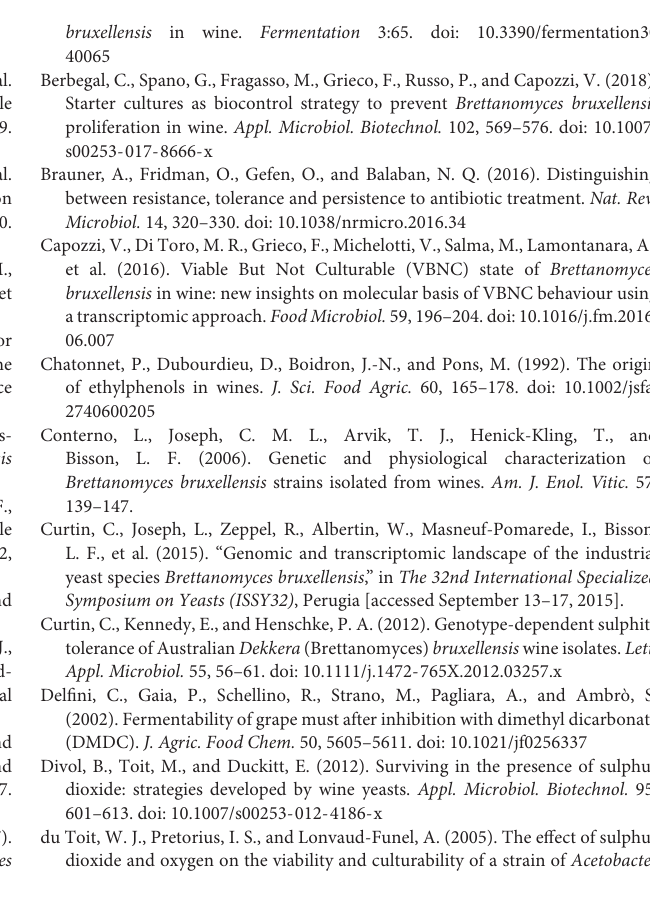
FIGURE S1 | Growth parameters of 145 B. bruxellensis isolates grown at different SO 2 concentrations. Growth parameters lag phase (h), maximum growth rate (division per hour), and maximum OD (600 nm) are presented for 145 isolates. Isolates are clustered by genetic group as defined previously (Avramova et al., 2018), in order: CBS 2499-like group (dark cyan), KOM1449-like (light green), AWRI1608-like (orange), AWRI1499-like (red), dark blue (CBS 5513-like), turquoise (L0308-like). Vertical traits present standard deviations. TABLE S1 | Growth parameters of B. bruxellensis strains in different concentrations of sulphur dioxide. a AWRI, The Australian Wine Research